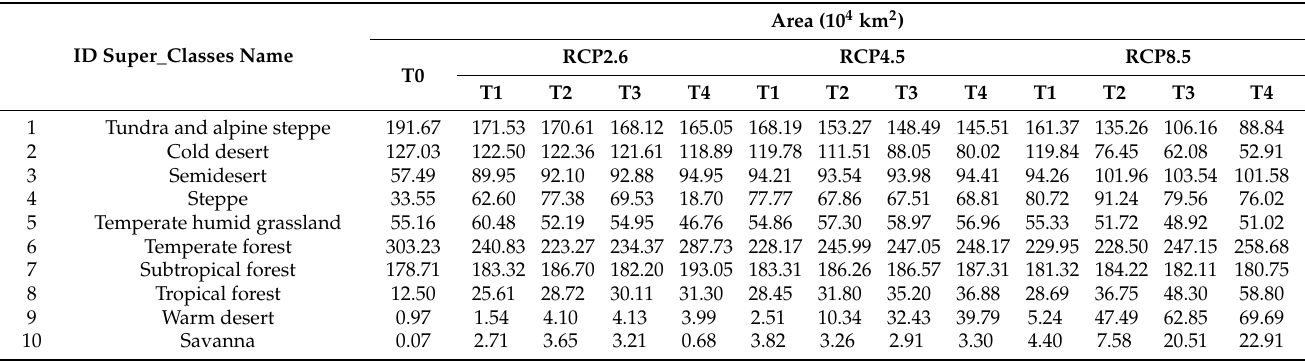
Figure 15. Areas changes of PNV super-classes in 2080s relative to 1970–2000 under RCP2.6, RCP4.5, and RCP8.5 scenarios. Table 5. The areas of each PNV type in China in the future climate